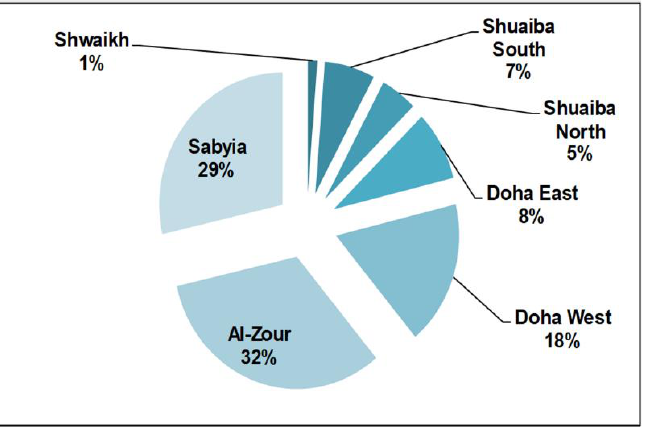
Figure 1. Breakdown (percentile) of power stations in Kuwait by carbon strength.